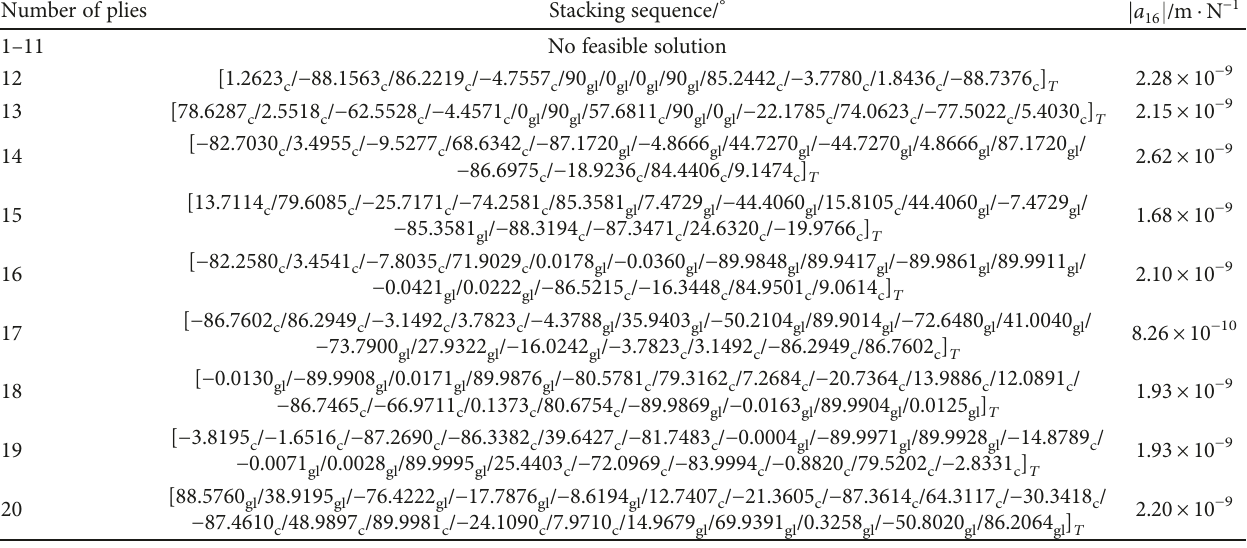
B D F 0 S laminates with immunity to HTSD.